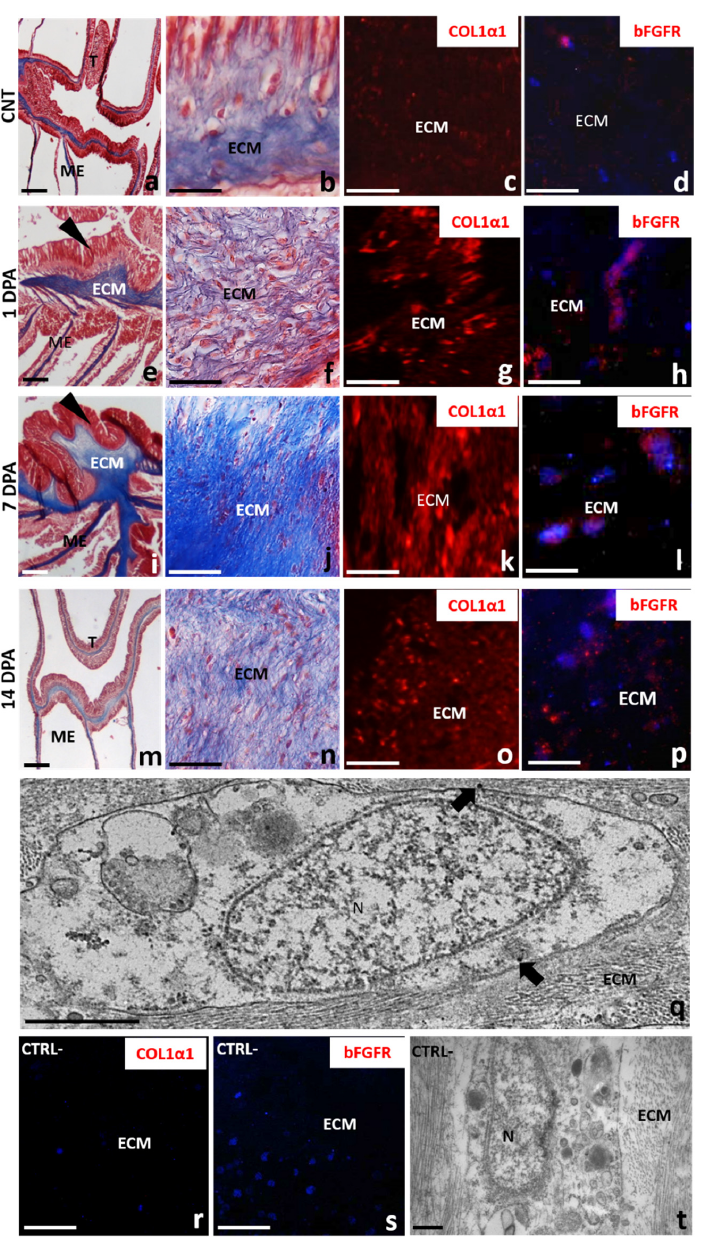
Figure 6. Masson’s trichrome and COL1 α 1/bFGFR immunolocalization assays. In control animals ( a – d ), Masson’s trichrome colorimetric assays highlighted the presence of a slightly colored ECM both in tentacles (T) and in the body wall (B) ( a , b ). A low immunofluorescent signal is detected for both anti-COL1 α 1 (red in c ) bFGFR (red in ( d )) primary antibodies, indicating the presence of few fibroblast-like cells involved in collagen production. After 1 dpa ( e – h ), an intensely blue-colored ECM ( e , f ), numerous dispersed COL1 α 1 + fibrils ( g ) and bFGFR + fibroblast-like cells ( g ) are detectable in the tentacle bud (arrowhead) and in the mesenteries (ME). After 7 dpa ( i – l ), a compact scaffold formed by collagen fibrils in which aggregates of COL1 α 1 + ( k ) and bFGFR + ( l ) spindle-shaped fibroblast-like cells are present in the ECM of both tentacle buds (arrow) and mesenteries. After 14 days ( m – p ), the ECM appears looser, less blue-staining ( m , n ) and low COL1 α 1 ( o ) and bFGFR ( p ) fluorescent signals are visible. ( q ) Immunogold localization at TEM showing the localization of bFGFR (arrows) on the fibroblast-like cell membrane. Nuclei are counterstained in blue by DAPI. No signals were detected in negative control experiments, in which primary antibodies are omitted ( r – t ). ECM, extracellular matrix of mesoglea; E, Epidermis; ME, mesenteries N-nuclei; T, tentacle. Scale bars—( a , e , i , m ) 100 µ m; ( b , f , j , n , r , s ) 20 µ m; ( c , d , g , h , k , l , o , p ) 5 µ m; ( q , t ) 500